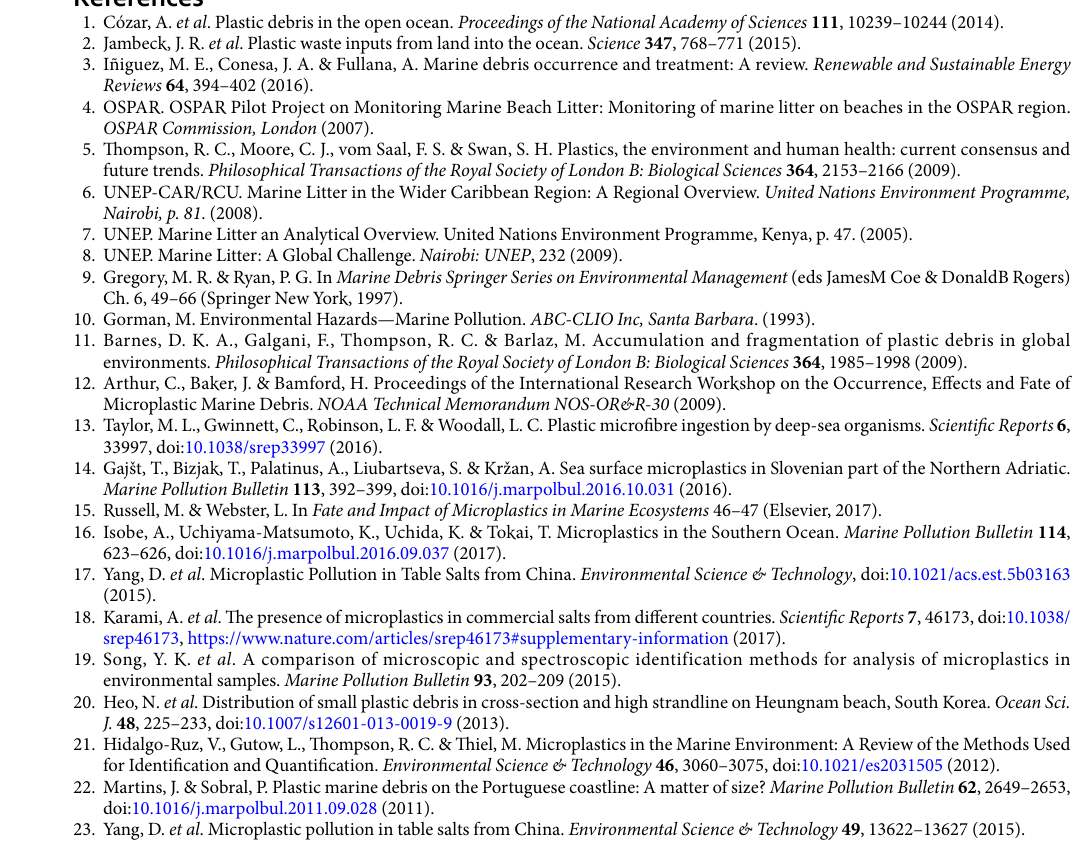
6 Scientific REPORTS | 7: 8620 | DOI:10.1038/s41598-017-09128-x